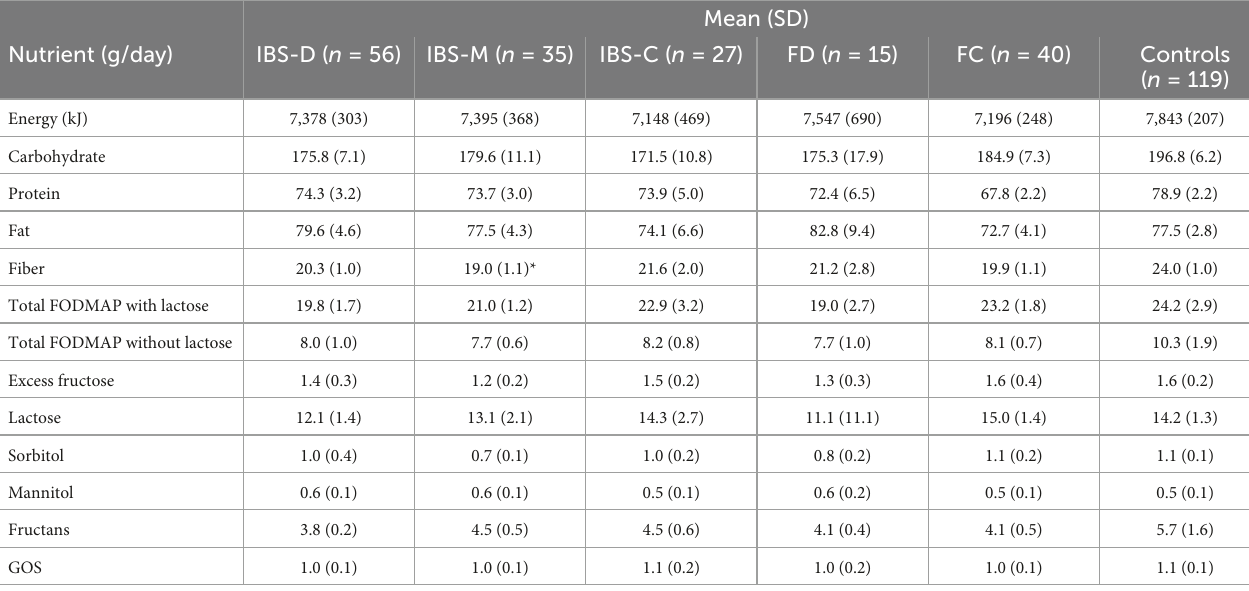
TABLE 2 Mean dietary intake of macronutrients and fermentable oligosaccharide, disaccharide, monosaccharide, and polyols (FODMAPs) between Rome IV diagnostic groups and controls.